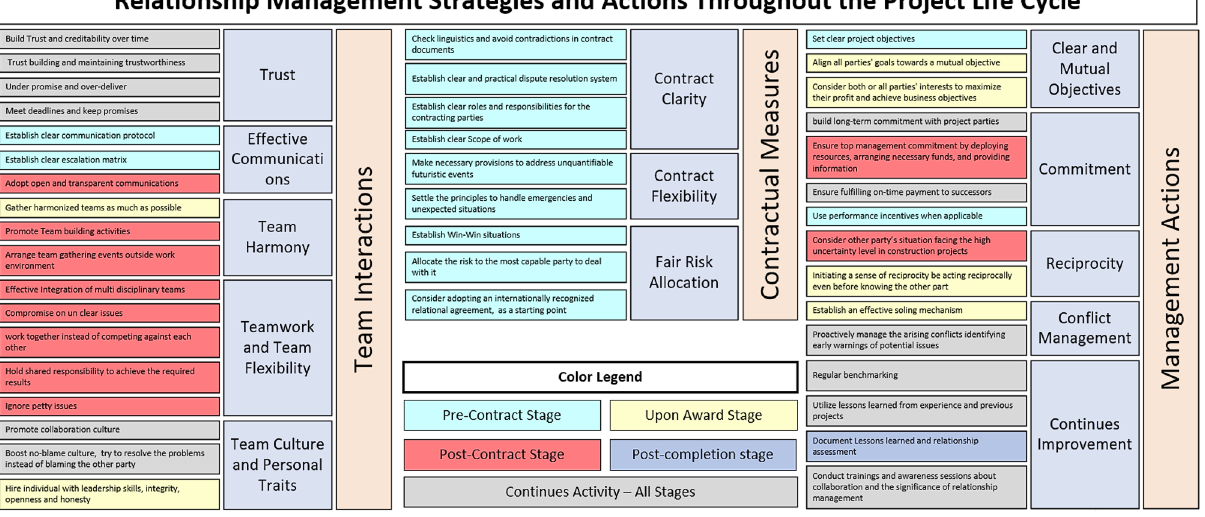
Figure 6. Relationship management strategies and actions throughout the project